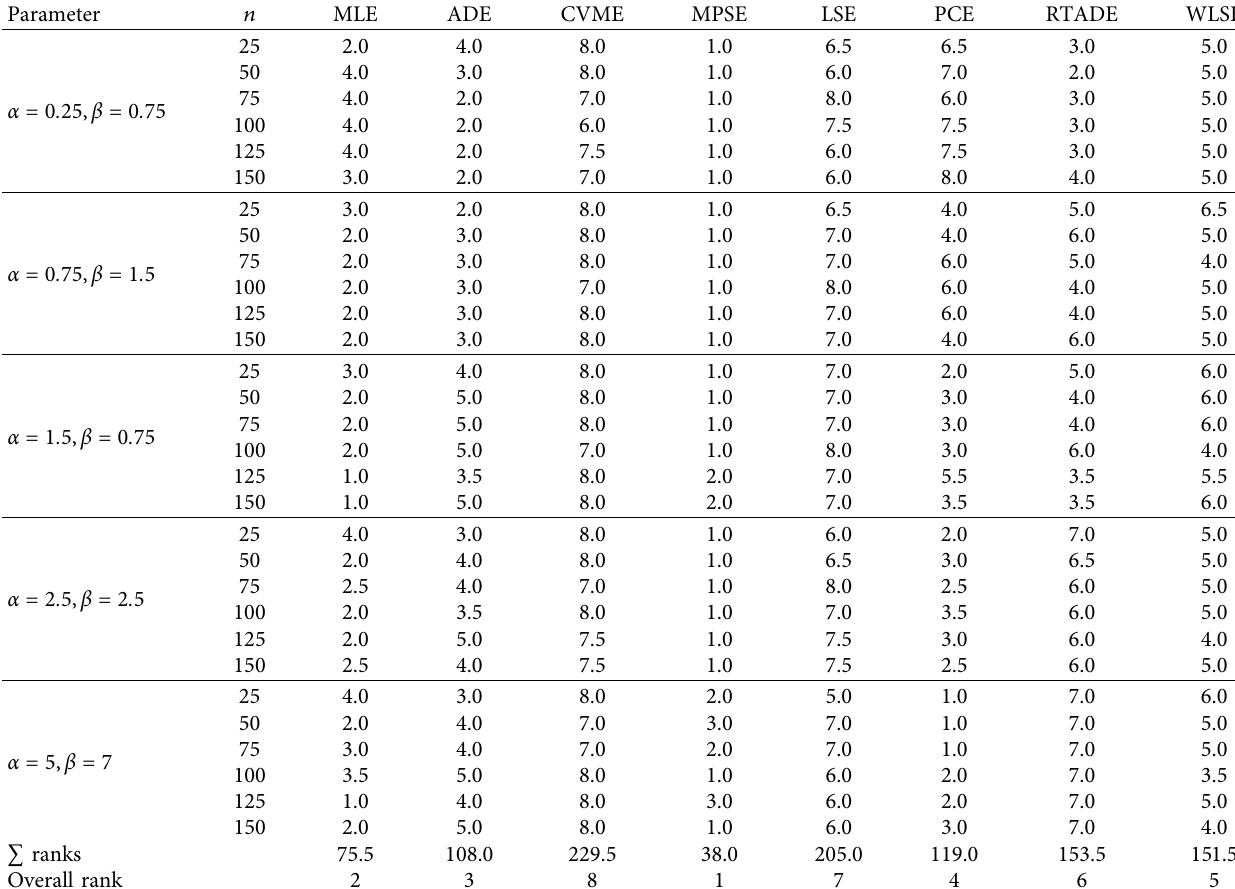
Table 6: Partial and overall ranks of all the methods of estimation of proposed distribution by various values of model parameters. Parameter n MLE ADE CVME MPSE LSE PCE RTADE WLSE 25 α � 0 . 25 , β � 0 . 75